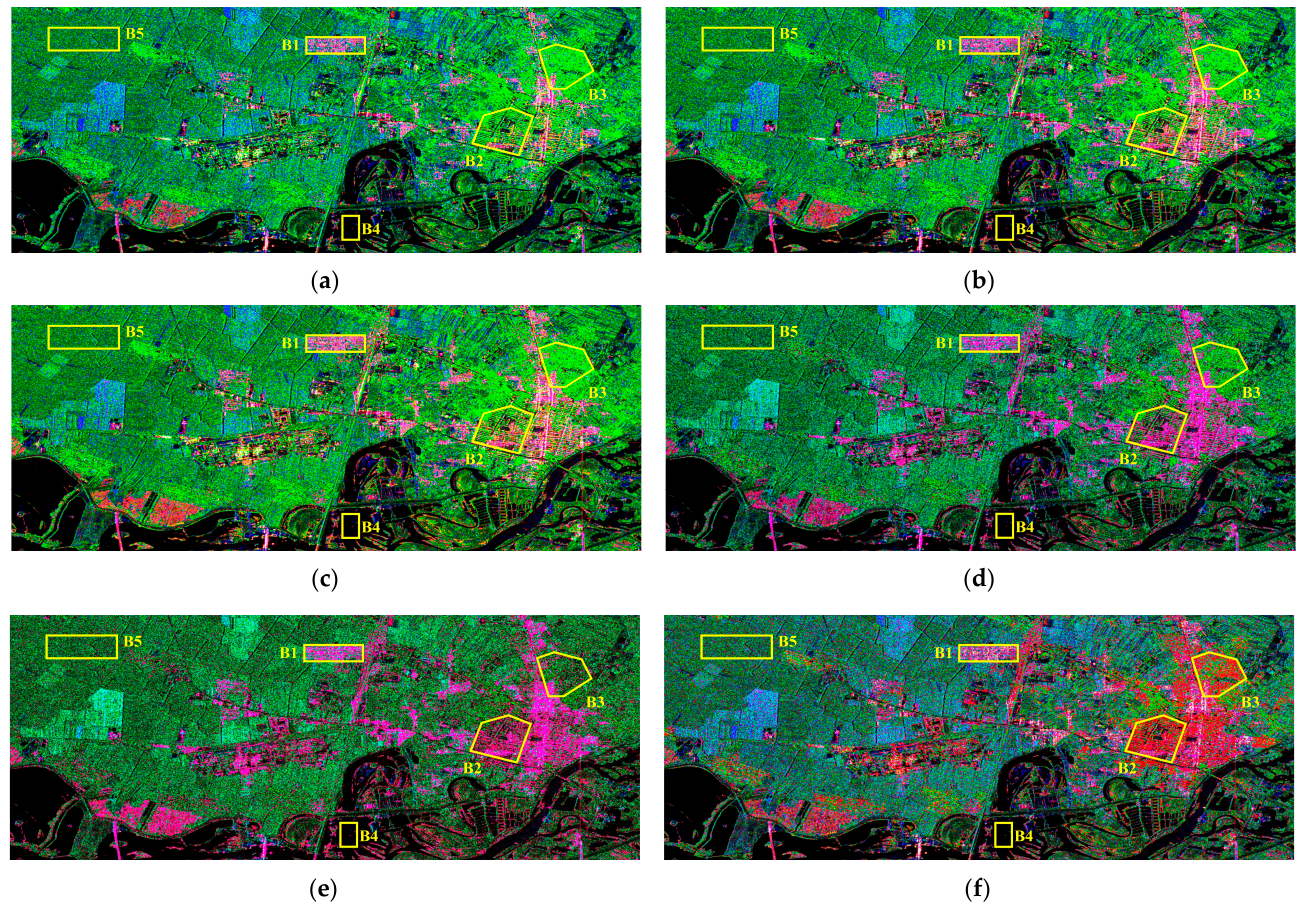
Figure 12. Decomposition results of GF-3 data sets over Harbin, China (RGB component: red: double-bounce scattering, green: volume scattering, blue: surface scattering). ( a ) Y4O, ( b ) Y4R, ( c ) G4U, ( d ) 6SD, ( e ) 7SD, ( f ) MRDM-5SD. Table 3. Scattering contributions (%) of Patch B1-B5 for GF-3 data sets. ROIs